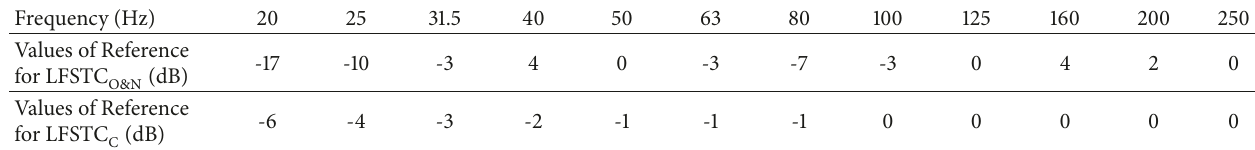
Table 1: Reference sound insulation contours for calculation of single-number